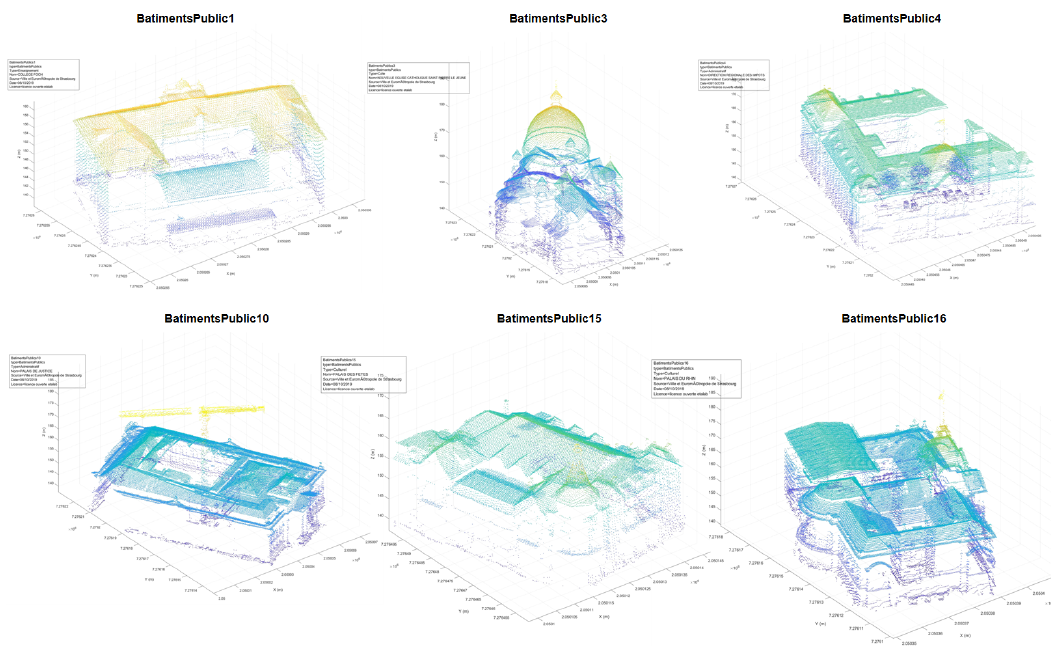
Figure 5. Results of the automatic segmentation and annotation (step 1 of M_HERACLES) for the St-Pierre dataset. Only six of the most important buildings are shown in this figure, of which BatimentsPublic3 represents the St-Pierre church which will be further processed. Note that only the aerial LIDAR data are